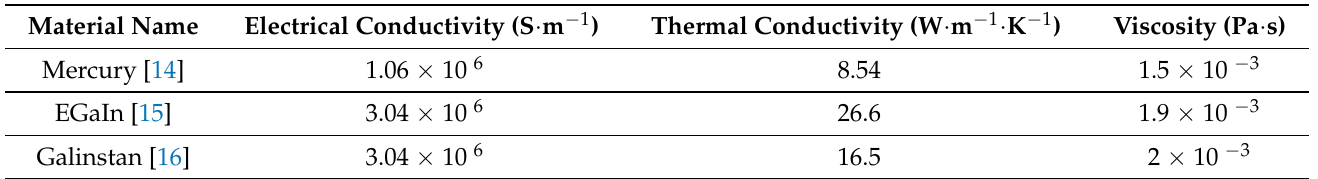
Table 1. Comparison of the different liquid metals alloys for sensor